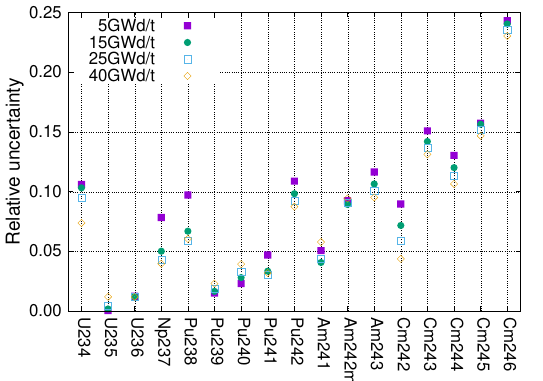
Figure 2. The Nuclear data-induced uncertainty of inventory data